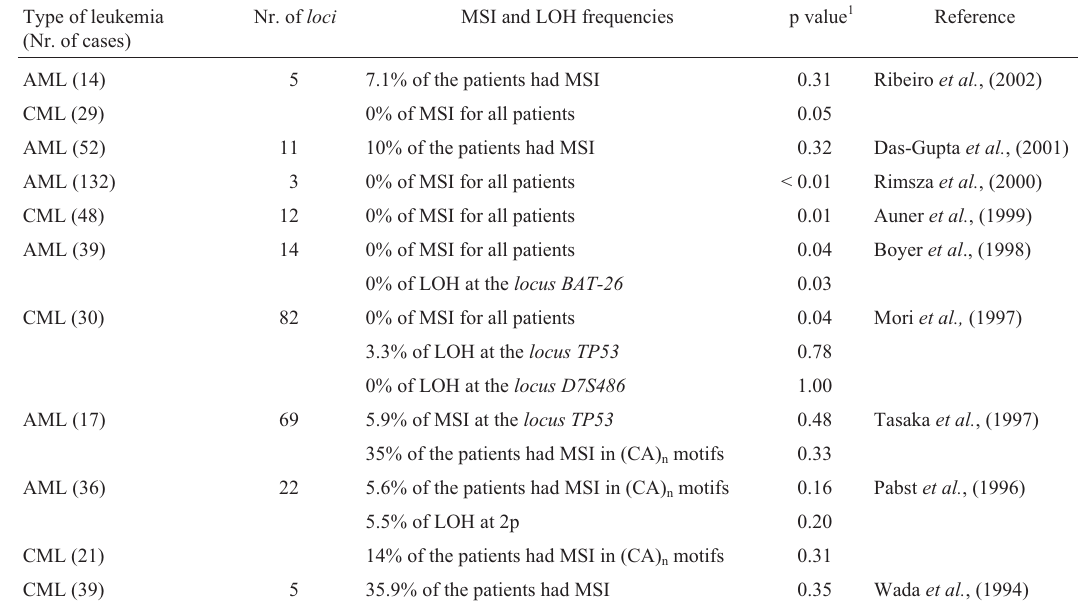
Table 3 - MSI and LOH frequencies in AML and CML reported elsewhere. Type of leukemia (Nr. of cases)